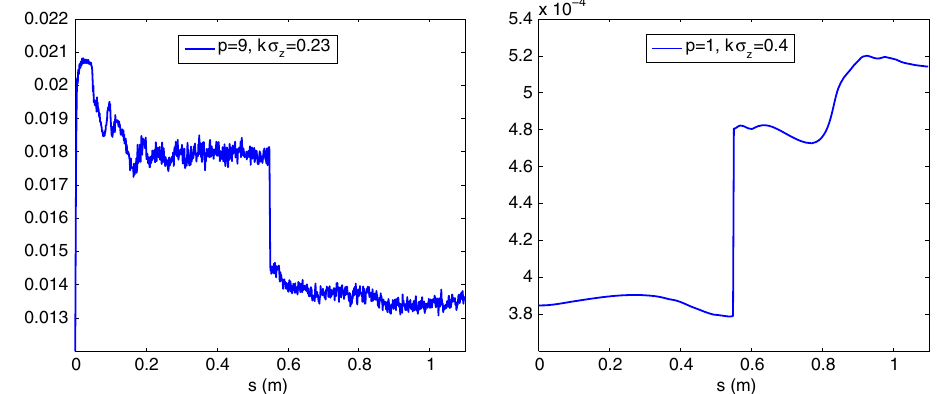
∥ ∂ 2 ˆ E = ∂ s 2 ∥ = 2 k ∥ ∂ ˆ E = ∂ s ∥ which should be small compared to 1 to justify the SVA E ¼ yp yp